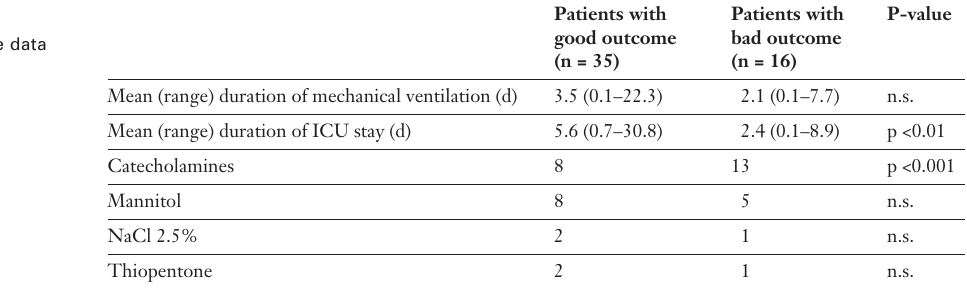
Intensive care data (n = 51).